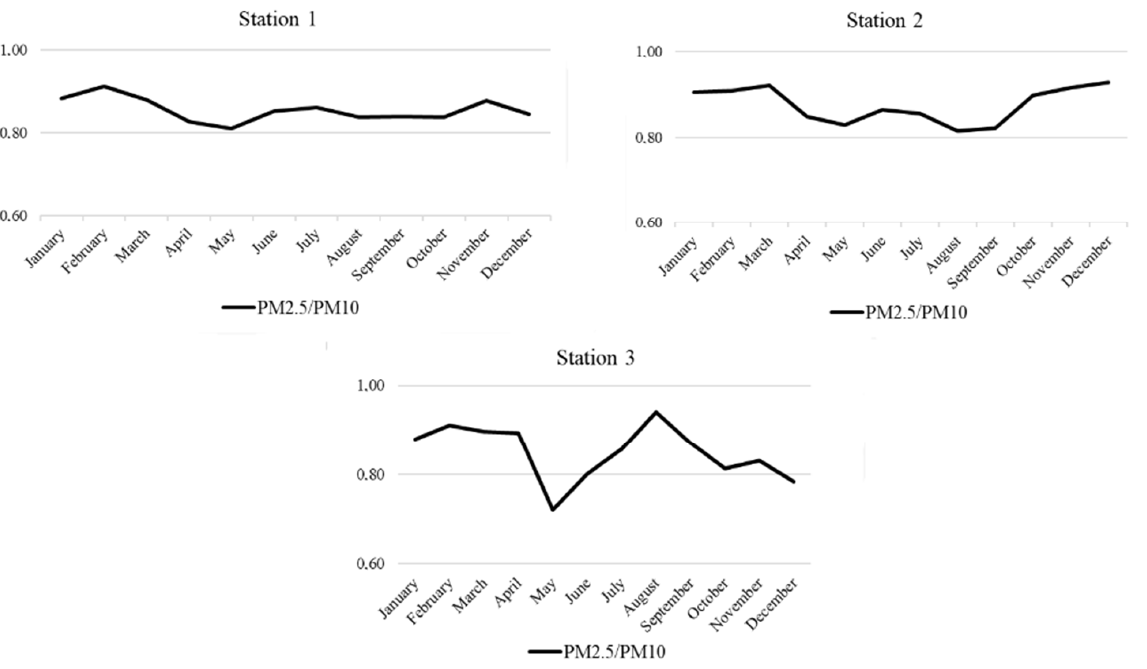
Figure 3. PM 2.5 /PM 10 ratio levels.